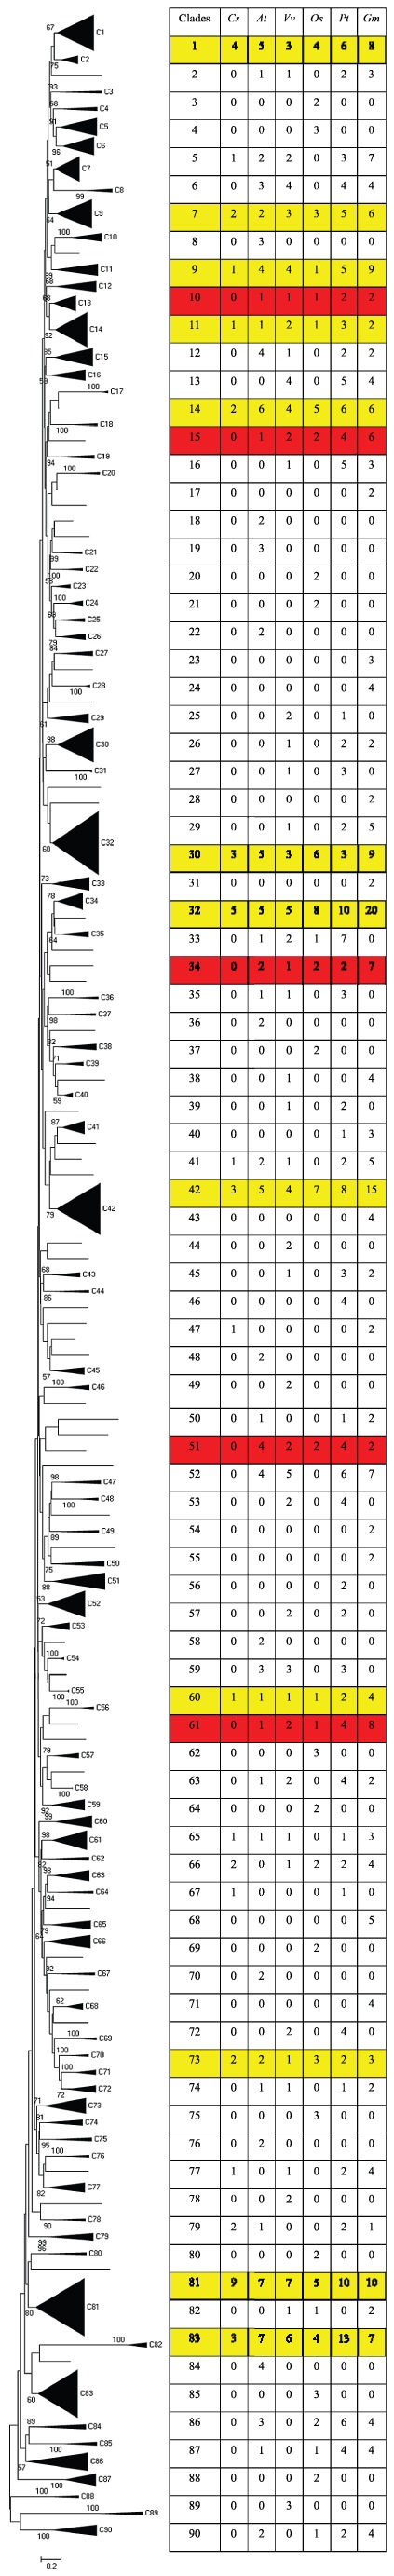
Phylogenetic relationships and subgroup designations in R2R3MYB proteins from cucumber (Cs), Arabidopsis (At), grape (Vv), rice (Os), poplar (Pt) and Soybean (Gm).The neighbor-joining tree includes 55 R2R3MYB proteins from cucumber, 126 from Arabidopsis, 117 from Vitis, 102 from rice, 197 from poplar and 244 from soybean. The bootstrap values lower than 50 are not shown in the phylogenetic tree. The proteins are clustered into 90 subgroups (triangles), designated with a subgroup number (e.g. C1). Forty eight proteins did not fit well into subgroups (lines). The membership of each subgroup is described in the table at right. Several subgroups are highlighted. 12 subgroups (yellow) are shared in all the 6 species. 5 subgroups (red) are shared among other 5 speices but not with cucumber. The uncompressed tree with full taxa names is available as Figure S2.